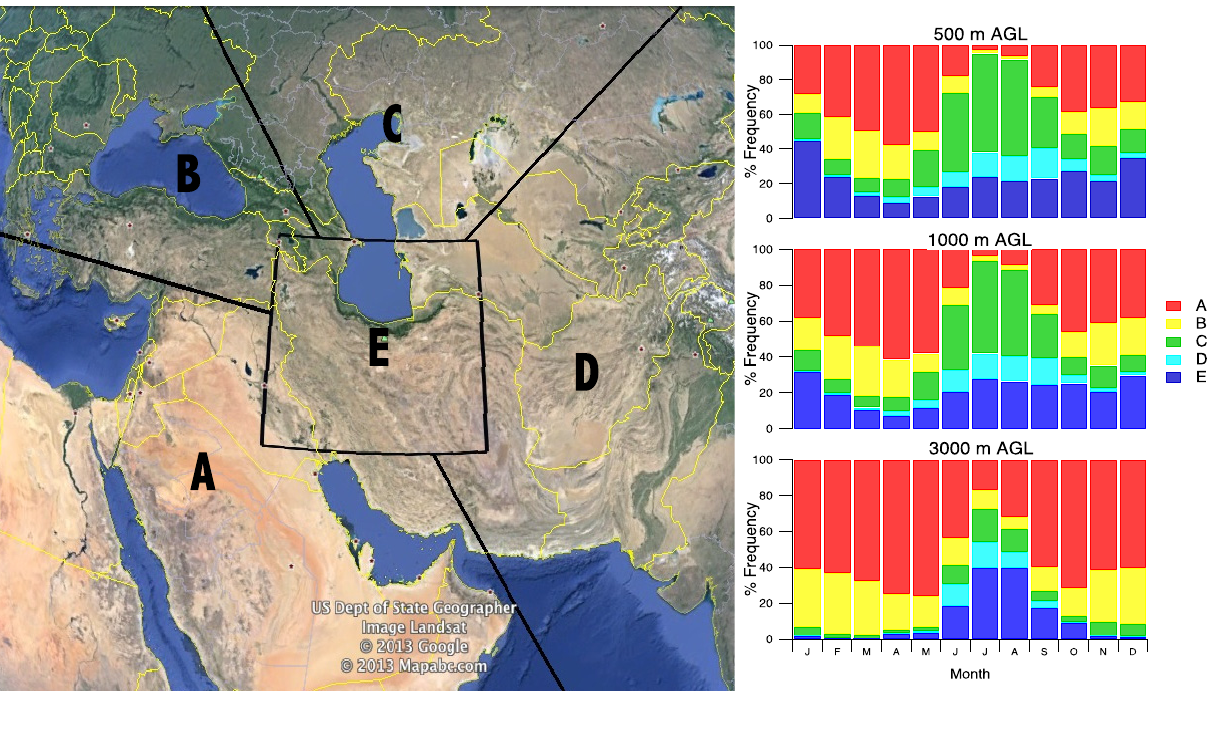
Figure 3. Monthly pattern in air mass source region as determined by analysis of daily Hybrid Single-Particle Lagrangian Integrated Trajectory (HYSPLIT) data between 2000 and 2009. Back-trajectories are classified by time spent in each region. The region totals are shown, by month, for end points at 500 m, 1000 m and 3000 m above ground level (AGL) ( Right